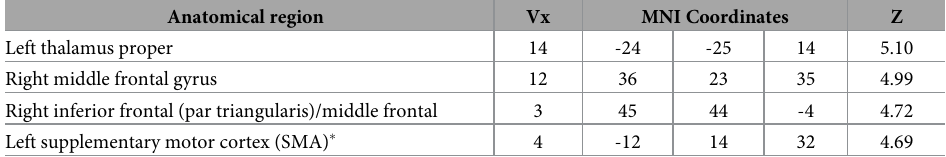
Right inferior frontal (par triangularis)/middle frontal Left supplementary motor cortex (SMA) (cid:3) 4.69 Stereotaxic brain MNI coordinates for peak-voxels of the functional interaction (NoGo-Go) sham > (NoGo-Go) stim . Results are represented at p FWE < 0.05 corrected at the voxel level (min cluster size = 3). Vx = voxel, Z = Z-score of the